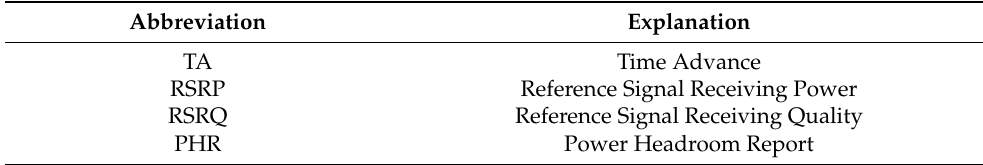
Table 1. Explanation of important features of MR.